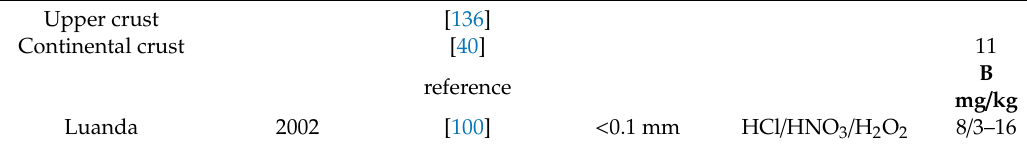
Table A24. Boron in road dust.